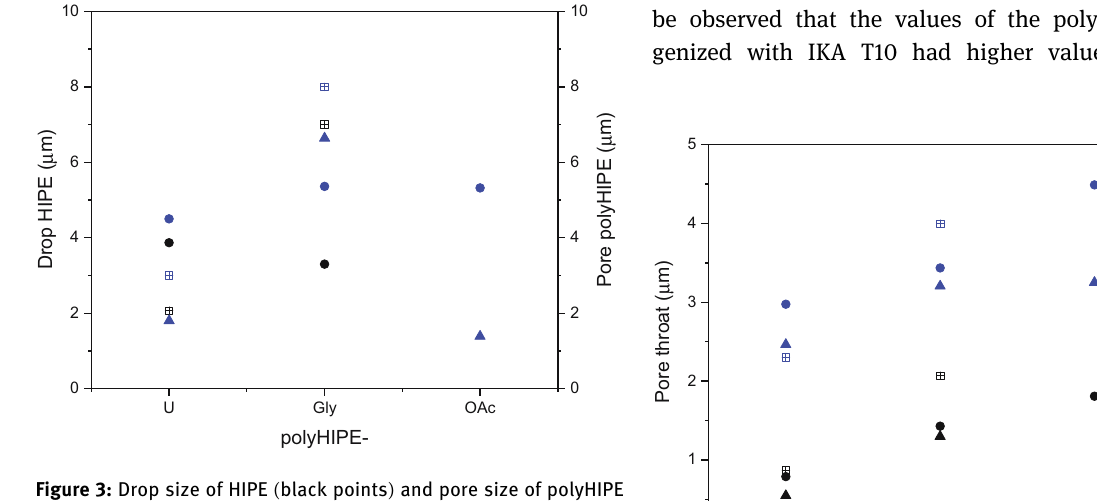
Figure 3: Drop size of HIPE ( black points ) and pore size of polyHIPE ( blue points ) using IKA T10 Ultra - Turrax® ( circles ) and IKA T18 Ultra - Turrax® ( triangles ) , to homogenize. Squares represent data taken from Peréz - García et al. ( 25 ) .